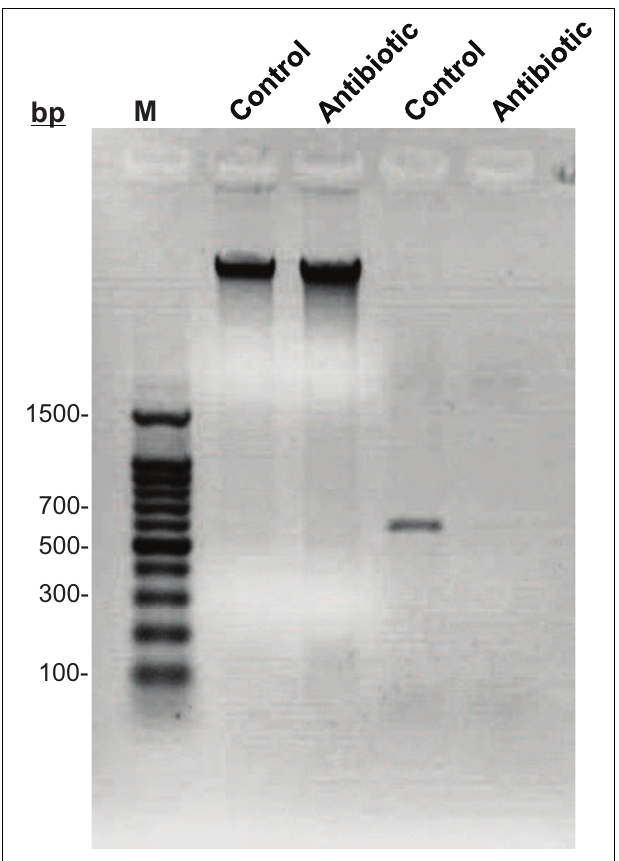
FIGURE 1 | Electrophoretic detection of Buchnera among symbiotic and cured aphids. Lane 1: 100bp ladder Marker; Lane 2: DNA of symbiotic aphids; Lane 3: DNA of rifampicin-cured aphids; Lane 4: PCR amplification of Buchnera in symbiotic aphids; Lane 5: PCR amplification of Buchnera in rifampicin-cured